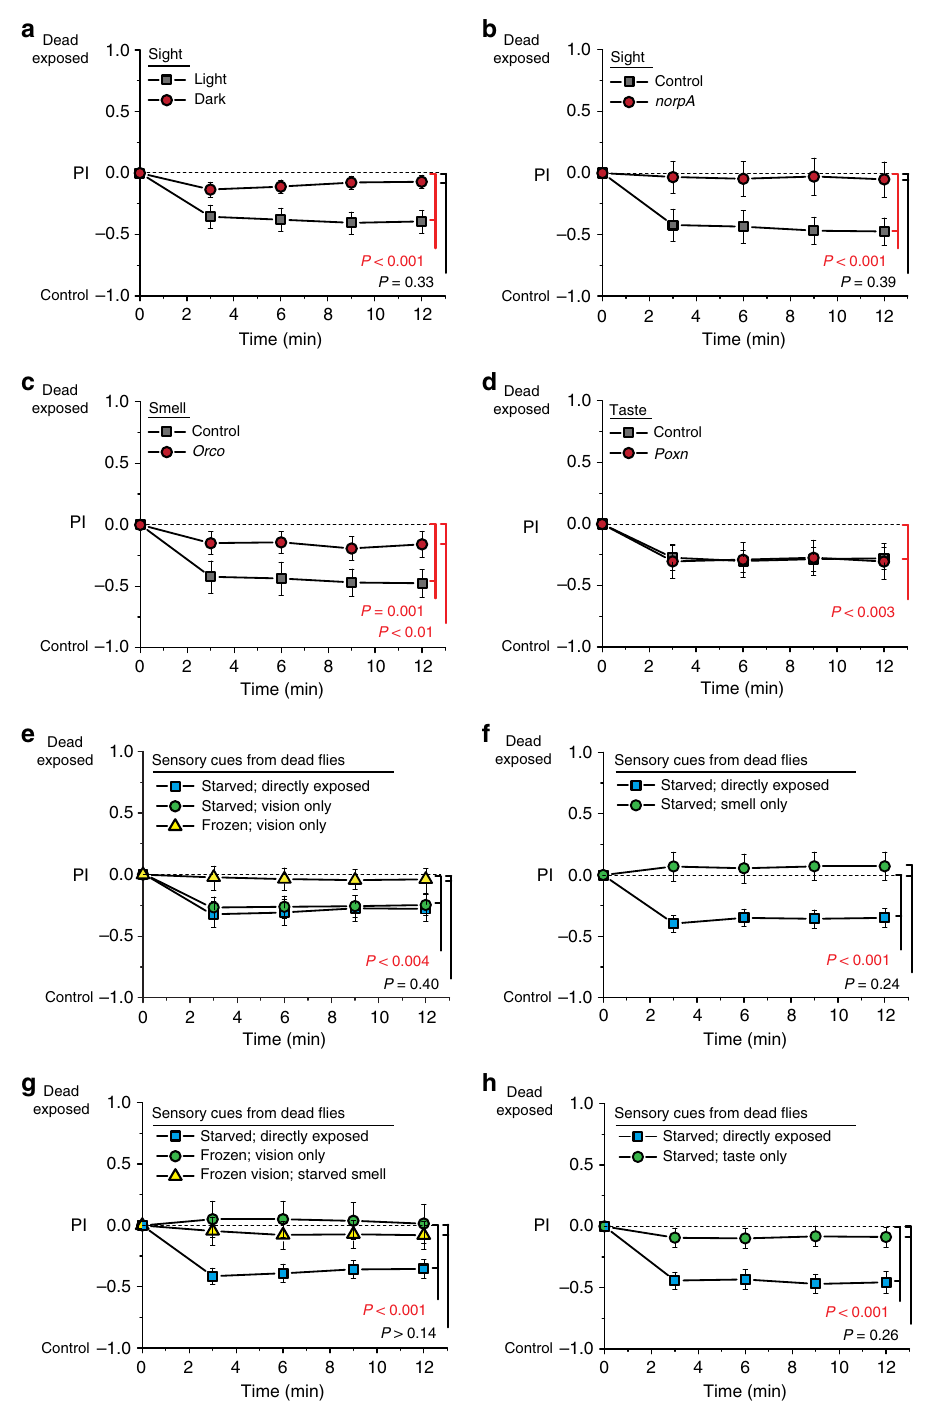
homogenized heads of experimental fl ies following 48 h of dead by exposure in norpA mutant fl ies (Fig. 5a; Supplementary exposure to that of unexposed animals. norpA mutant fl ies, which Fig. 10a). The multivariate analysis revealed that fi ve of the top were treated identically but which lacked the ability to see dead ten metabolites associated with the effects of exposure to dead fl ies, were analyzed simultaneously to account for temporal effects fl ies (i.e., those strongly loaded on PC10) have been implicated in and to isolate potential causal metabolites. Targeted metabolite models of anxiety, depression, and/or mood disorders in mam- analyses identi fi ed 119 metabolites present in treatments for mals (speci fi cally lactate 31 , quinolinate 32 , sorbitol 33 , 3- hydroxybutyric acid 34 , and sarcosine 35 ). In addition to our sys- positive and negative modes (see Supplementary fi le for raw tems biology analysis, we also asked whether any individual data). Using a randomization procedure together with principal metabolites were statistically correlated with exposure to dead component analysis (PCA), we identi fi ed a single principal individuals in experimental but not norpA mutant fl ies (i.e., component (PC10) that signi fi cantly distinguished the neuro- exhibited a statistically signi fi cant interaction between metabolomes of exposed and unexposed fl ies but was unchanged NATURE COMMUNICATIONS| (2019) 10:2365